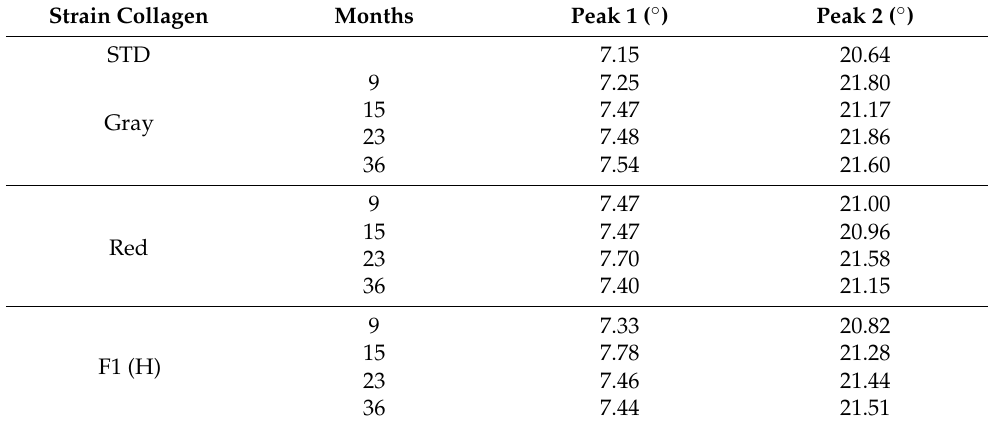
Table 4. X-ray diffraction pattern estimates of tilapia skin collagen samples at 9, 15, 24, and 36 months. Strain